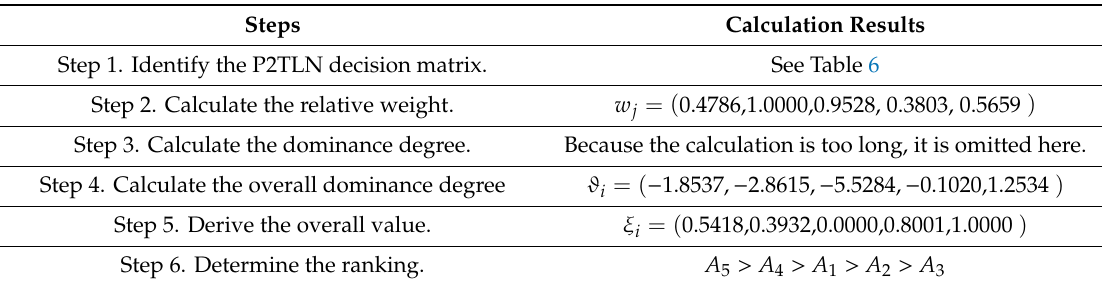
Table 23. P2TL-TODIM calculation